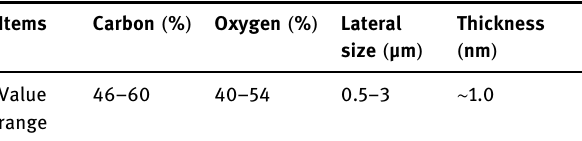
Table 3: Compositions and dimensions of GO